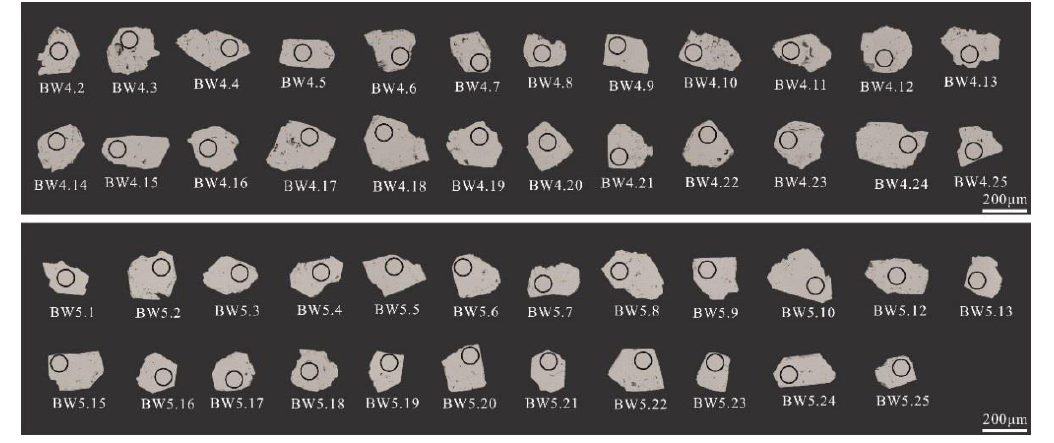
Figure 5. The backscattered electron (BSE) images of cassiterites from the Bawang deposit.